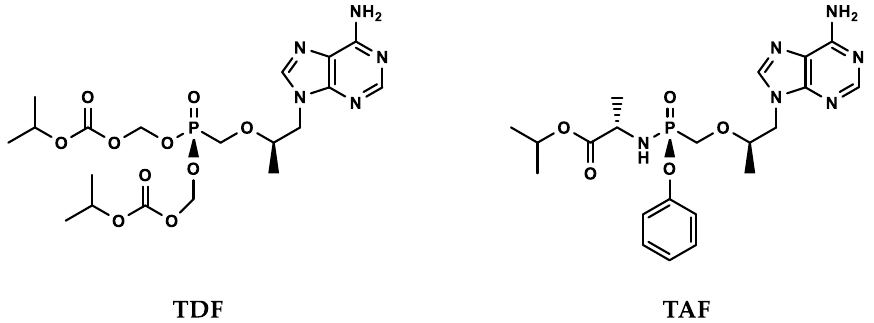
Figure 2. Two prodrugs of tenofovir—once daily oral dosing. TDF: tenofovir disoproxil fumarate; TAF: tenofovir alafenamide.